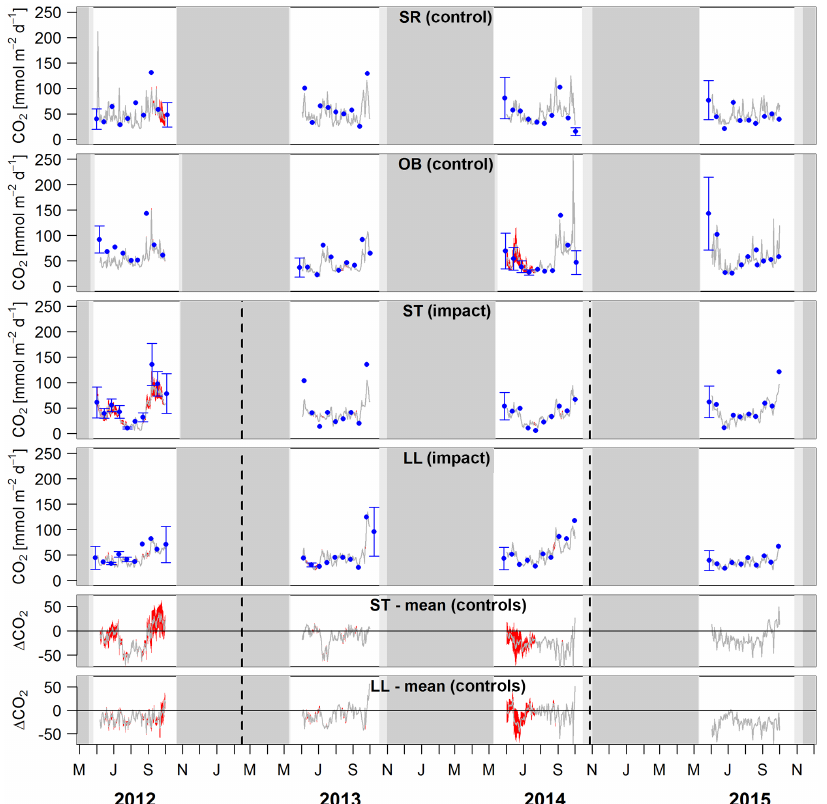
Figure 4. Time series of lake–atmosphere CO 2 fluxes based on daily means of 2-hourly concentration measurements (grey lines), biweekly spot measurements (blue dots), and the k model by Cole and Caraco (1998). Given are absolute fluxes and differences ( (cid:49) CO 2 ) between impact and control lakes. Shadings and error bars show propagated standard errors (see Fig. S3 and Text S6). Gap-filled data are colored in red. Bars show the lake ice cover duration with uncertainties expressed by grey scale (dark = minimum duration, light = maximum duration). Dashed lines mark the timing of forest clear-cutting (2013) and site preparation (2014). Units are consistent across all panels. Abbreviations: SR is Stortjärn, OB is Övre Björntjärn, ST is Struptjärn, and LL is